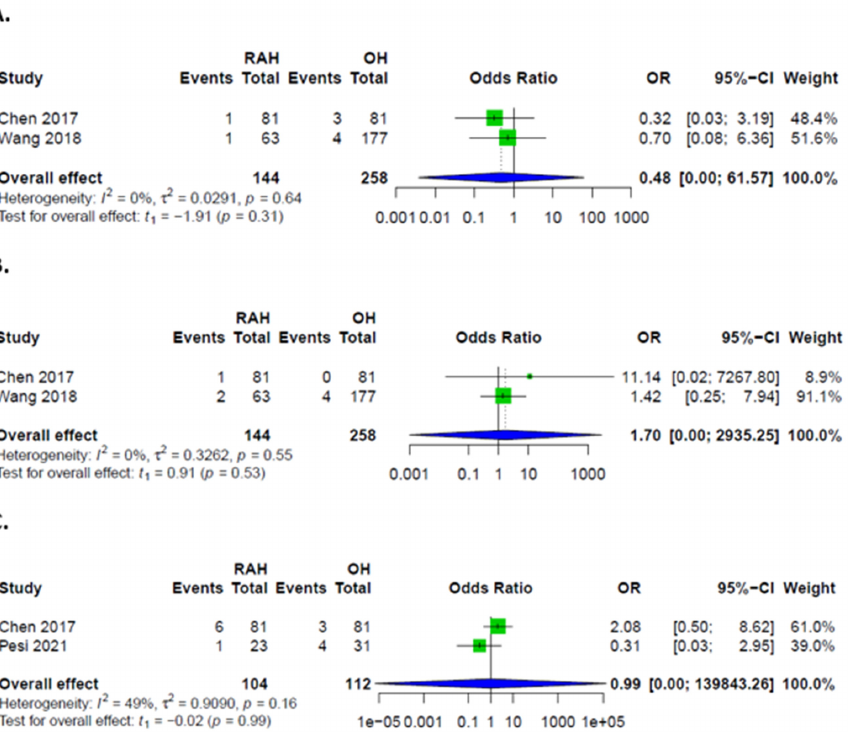
Figure 9. Forest plots for complications; ( A ) Overall complications in patients after RAH and OH; ( B ) Major complications in patients after RAH and OH; ( C ) Minor complications in patients after RAH and OH.